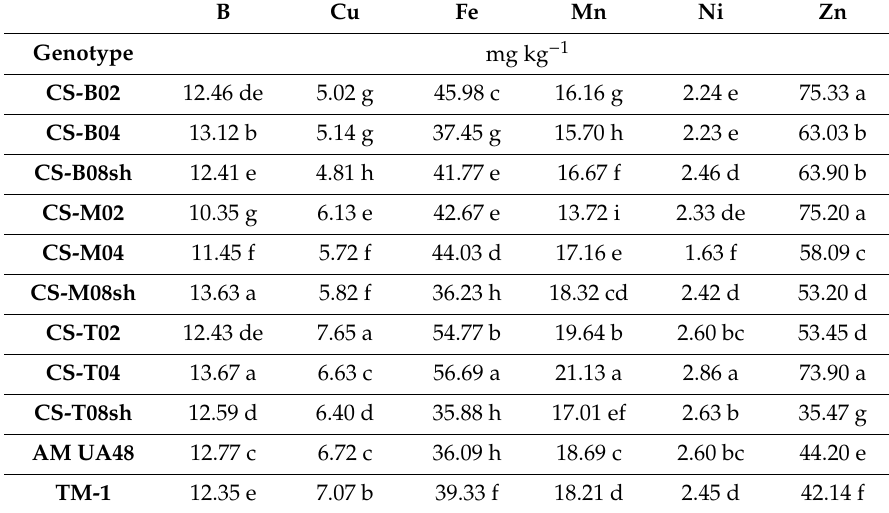
Table 2. Experiment 1: E ff ects † CS on cottonseed mineral concentrations (mg kg − 1 ). The experiment was conducted in 2013 in Florence, SC, USA.